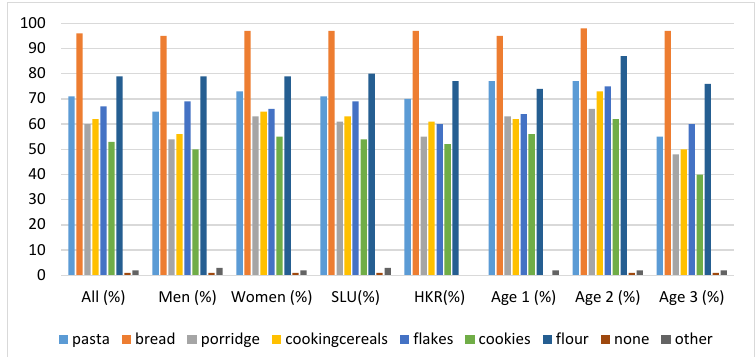
Figure 5. Future willingness to purchase heritage cereal products. The category “others” includes drinks, smoothies, beer brewing, alcoholic beverages and everything today that is done by modern cereals.